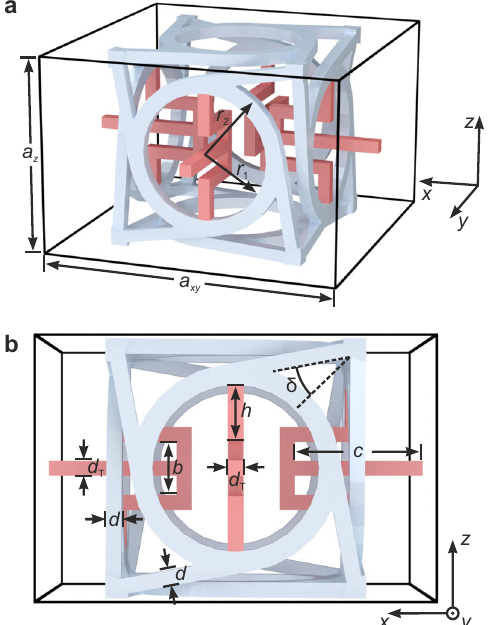
Fig. 1 Illustration of one unit cell of the chiral tetragonal mechanical metamaterial considered here. a , b Different viewing directions. All are made from one material, the colors are for illustration only. Within the xy - plane, adjacent unit cells are connected only by the red arms of length 2 c and width d T . In the z -direction, the unit cells are connected directly. The blue cubic part in the middle is identical to that in ref. 2 with radii r 1 , r 2 , and angle δ of the arms with respect to the cubic face diagonal. A non-zero δ makes the unit cell chiral. This tetragonal unit cell with lattice constants a = a = a = 74 µ m or a = 150 µ m (depending on the fabrication x y xy xy technique) and a z = (2/3) × a xy is placed on a tetragonal translation lattice. Further geometrical parameters used throughout this paper are: r 1 / a xy = 21.3%, r 2 / a xy = 26.7%, b / a xy = 14.2%, c / a xy = 34.2%, d / a xy = d T / a xy = 4%, h / a = 14.2%, δ = xy